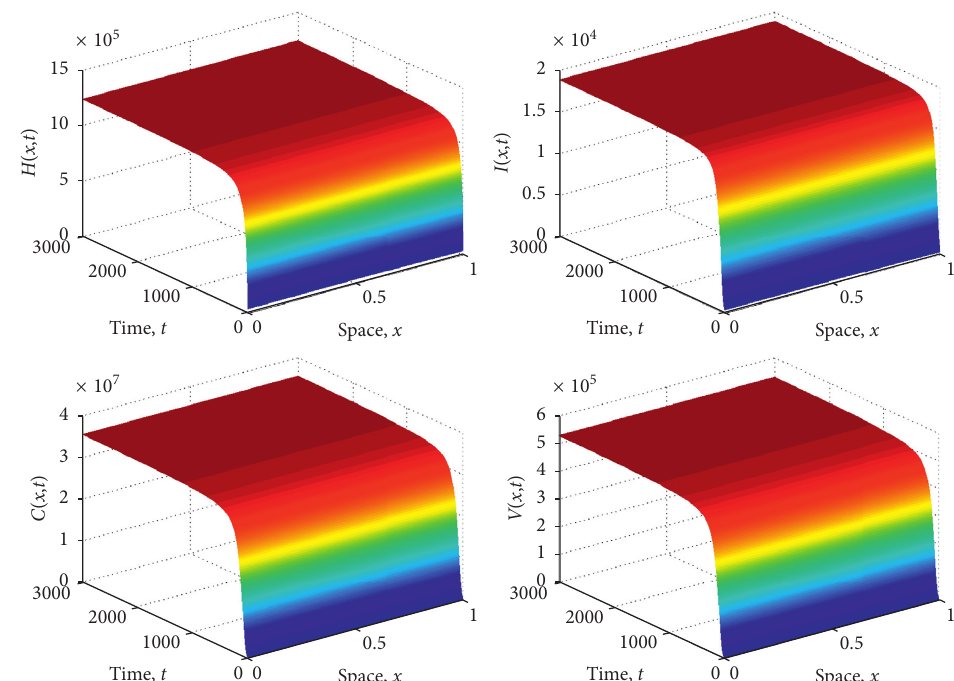
Figure 2: Stability of the chronic infection steady state P